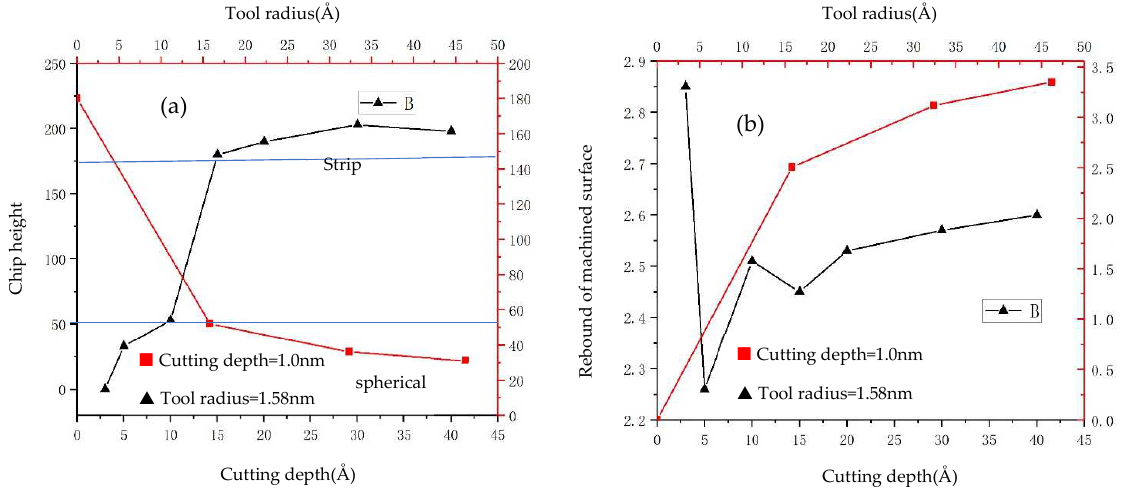
Figure 4. Line plots of chip height and rebound. ( a ) Variation in chip height when the cutting depth was 1 nm and tool radius was 1.58 nm; and ( b ) variation in rebounding on the machined surface when the chip depth was 1 nm and the tool fillet was 1.58 nm.